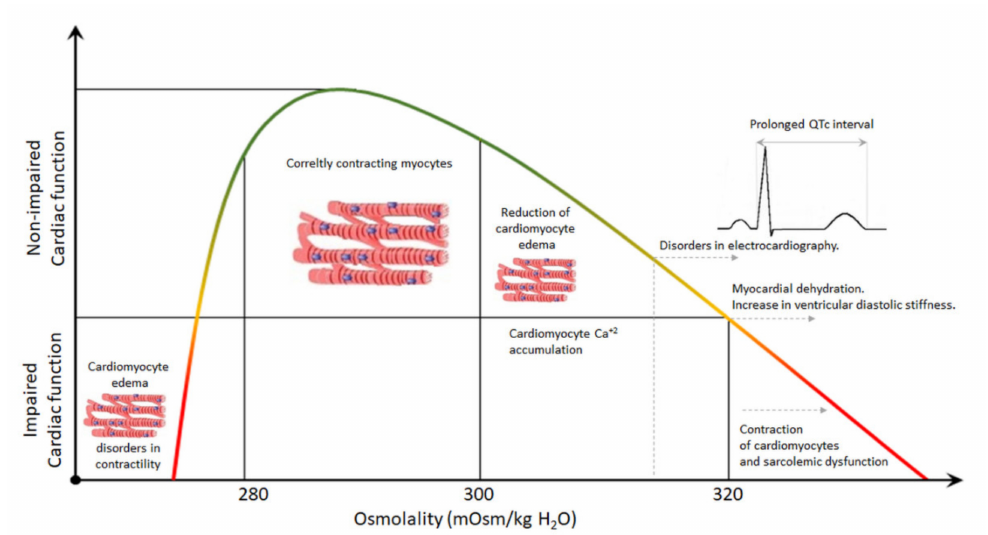
Figure 2. General scheme showing the effect of hyperosmolality on the